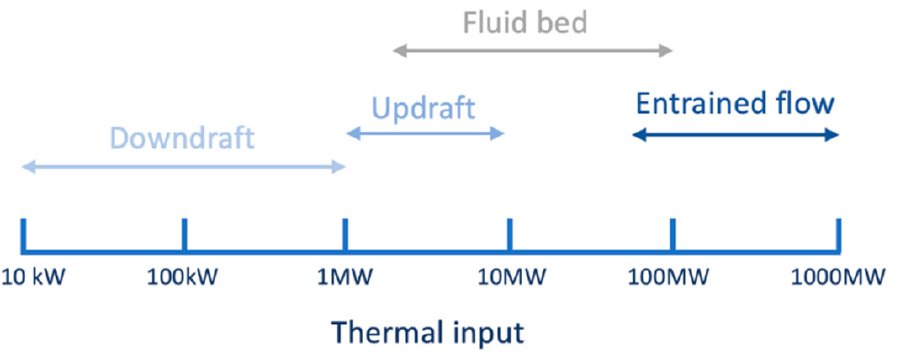
Figure 7. Range of power generation applicability for biomass gasifier types. Table 9. Comparison between different types of commercial gasifiers [69,91].